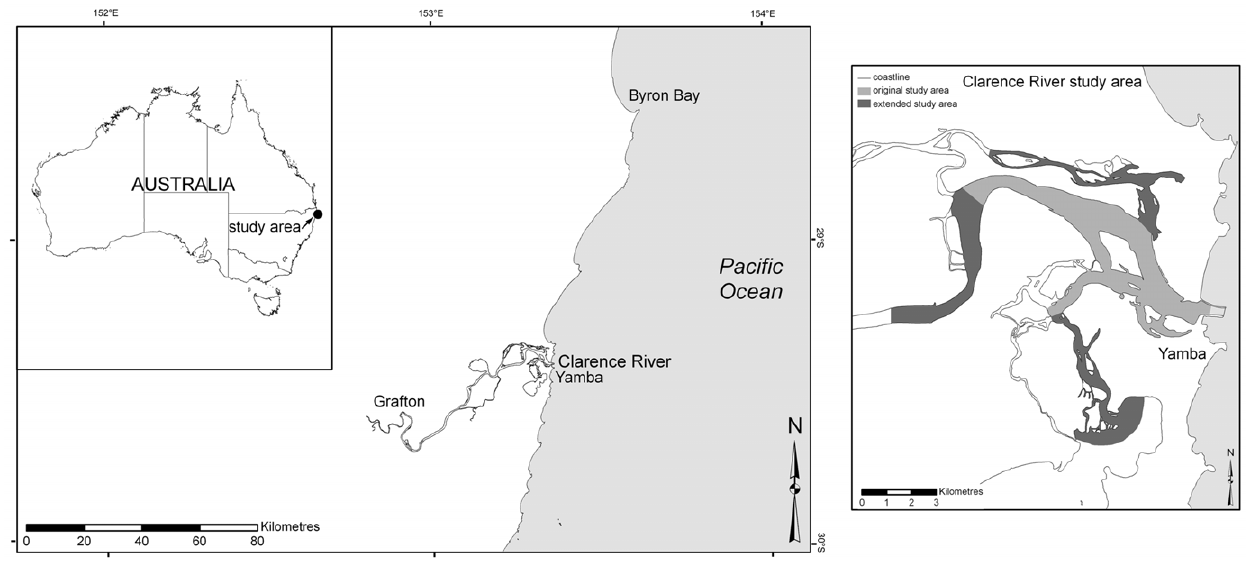
Figure 1. Map of the study sites in northern New South Wales, Australia at the top and a detailed map of the Clarence River estuaries indicating the survey areas.